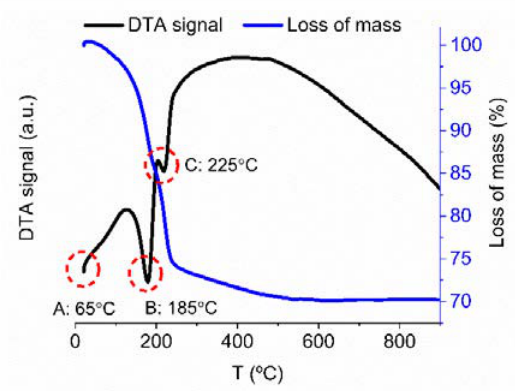
Figure 1. TGA-DTA results of the CoAl hydrotalcite precursor.